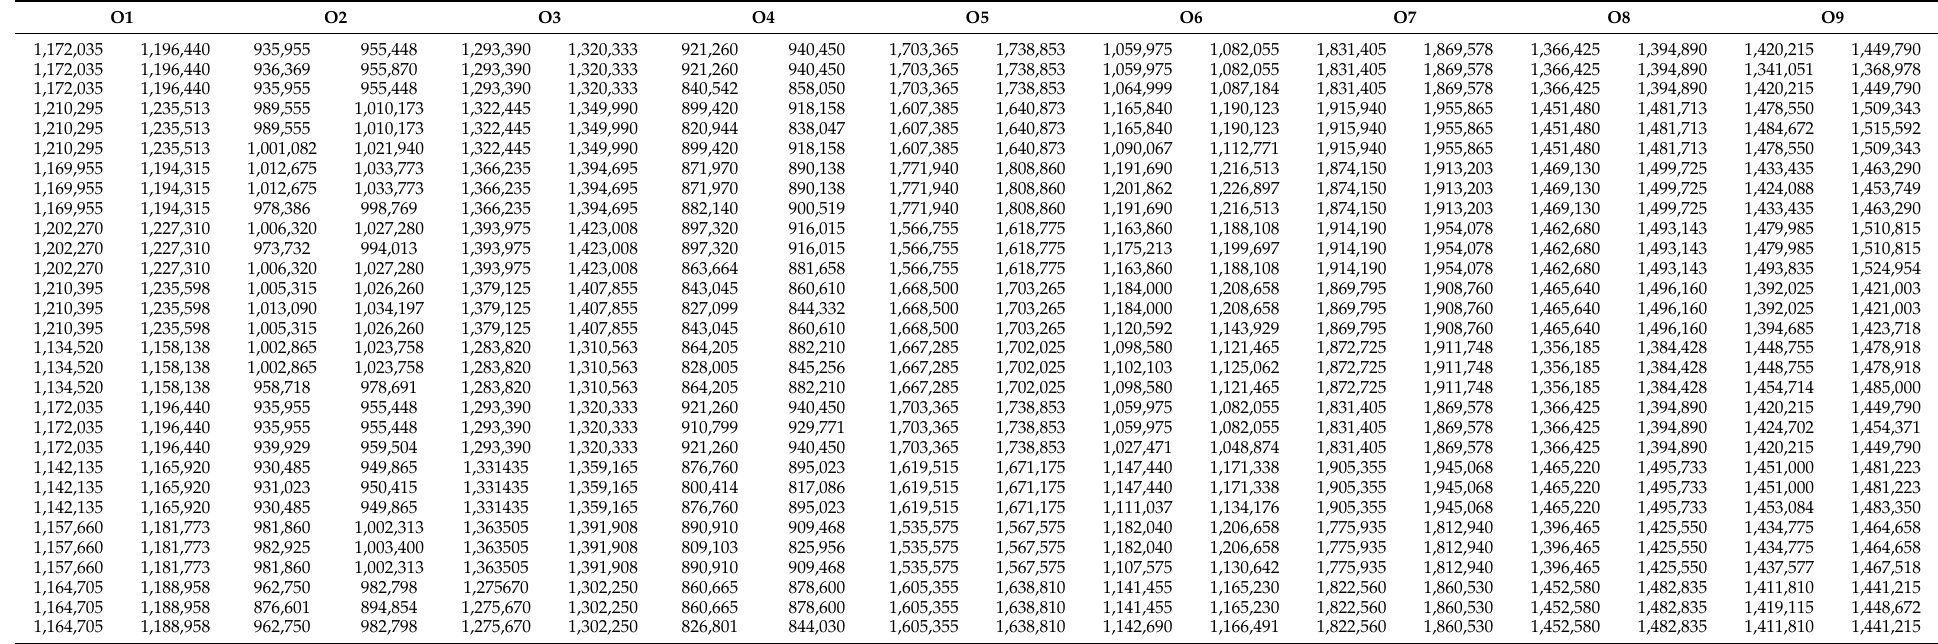
Table A7. Limiting boundaries (three limiting solution for each DM).